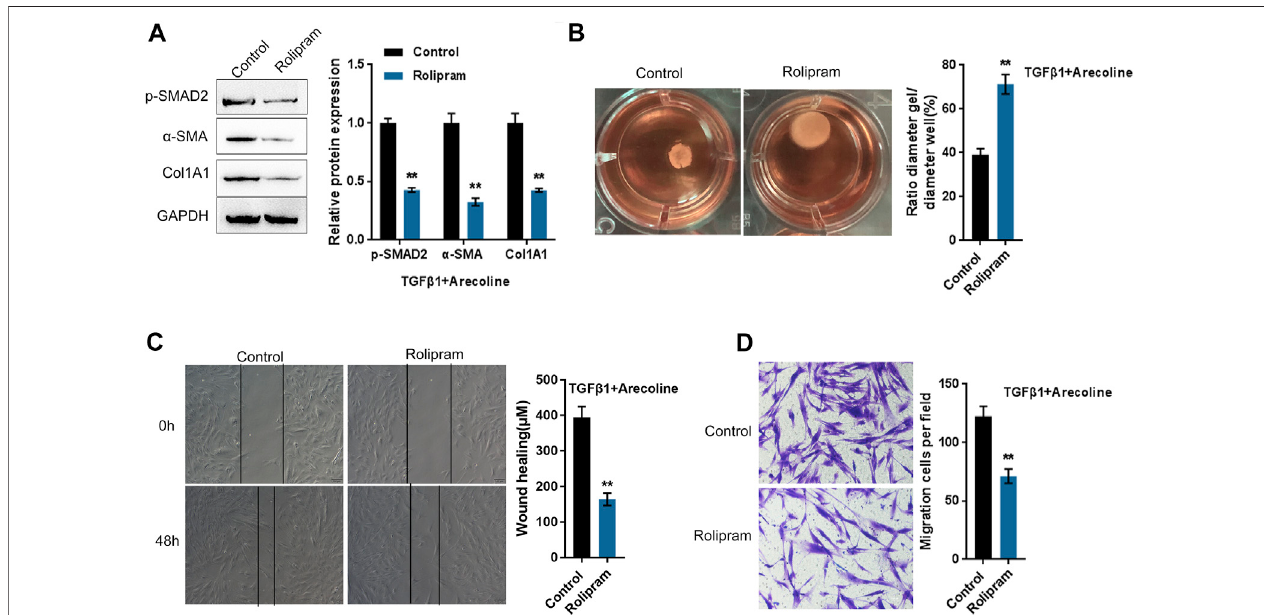
FIGURE 4 | Arecoline regulates TGF- β 1-induced BMFs activation by affecting the activity of PDE4A. BMFs were co-treated with 50 µg/ml arecoline and 5 ng/ml TGF- β 1 in the presence or absence of PDE4 speci fi c inhibitor Rolipram, and then examined for (A) the protein levels of p -Smad2, α -SMA, and Col1A1, n (cid:1) 3; (B) the gel contraction capacity, n (cid:1) 3. (C,D) the migration capacity by Wound healing and Transwell assays, n (cid:1) 3 ** p < 0.01 compared with the control group, student t